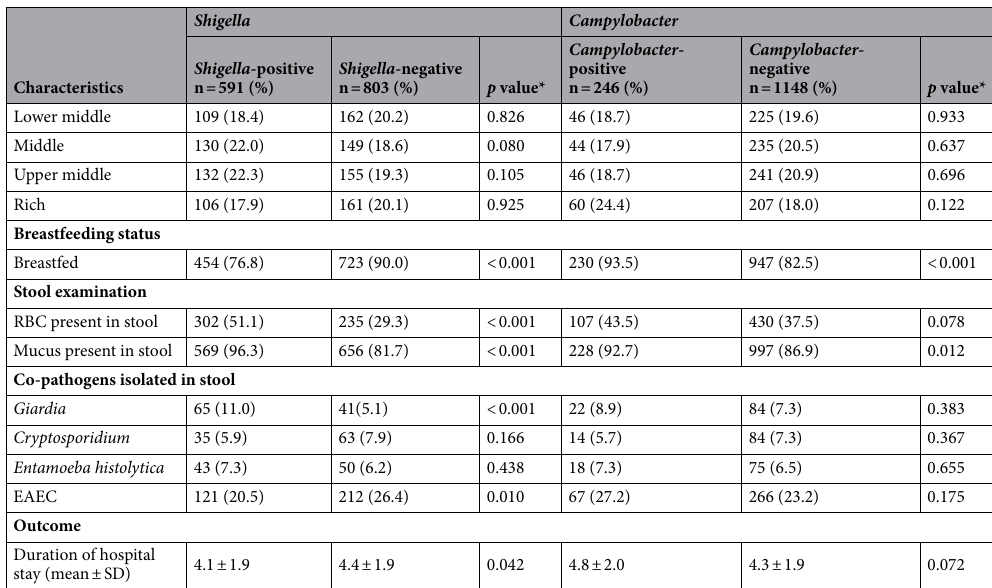
Table 1. Baseline characteristics of the Shigella -positive and Campylobacter -positive under 5 Bangladeshi children having MSD. Stunting: HAZ < − 2, (%; for < 5 years of age), Underweight: WAZ < − 2, (%; for < 5 years of age), Wasted: WHZ < − 2, (%; for < 5 years of age), MUAC, (mean; for < 5 years of age) Mid upper arm circumference, RBC, red blood cell, Diarrhea: 3 or more loose watery stool/day, Fever: measured at least 38°C or parental perception; WASH, water, sanitation, and hygiene; EAEC, enteroaggregative E. coli ; SD, standard deviation. *Variable was added in multiple models if p < 0.25 in bi-variate